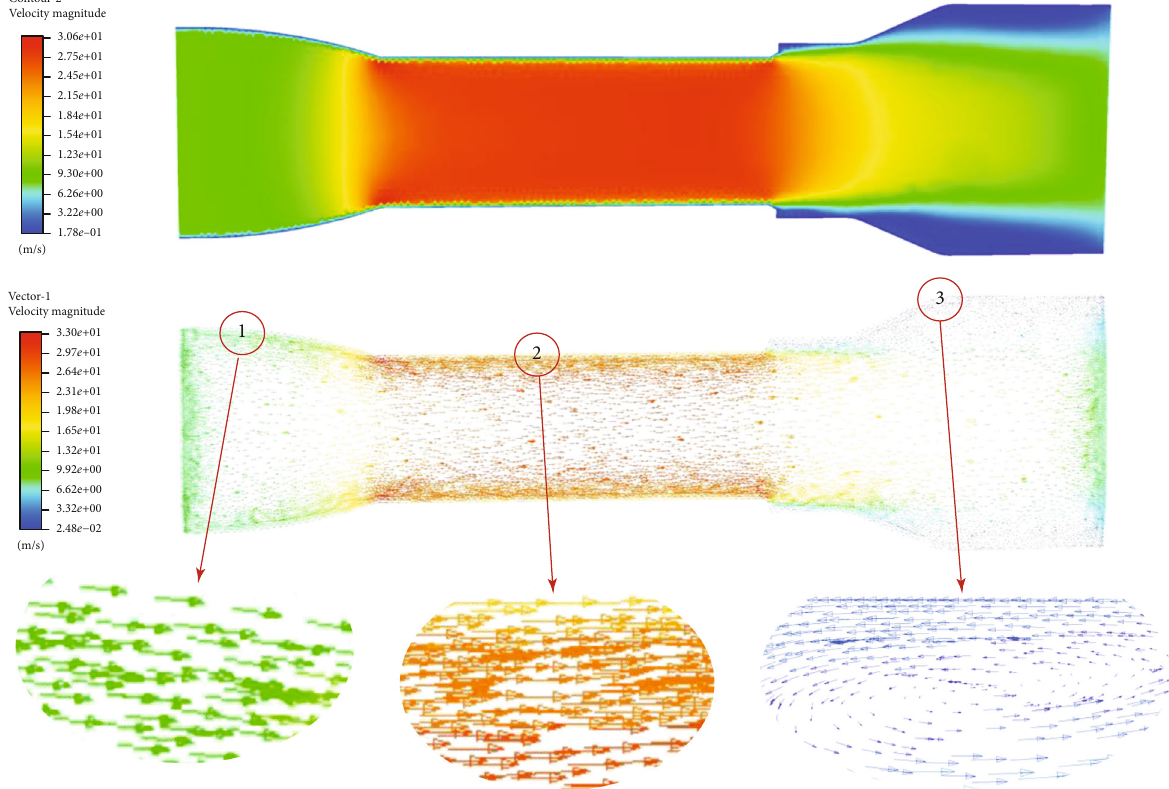
Figure 11: Cloud and vector diagrams of drilling fl uid velocity in the axial cross section of the coupled model.